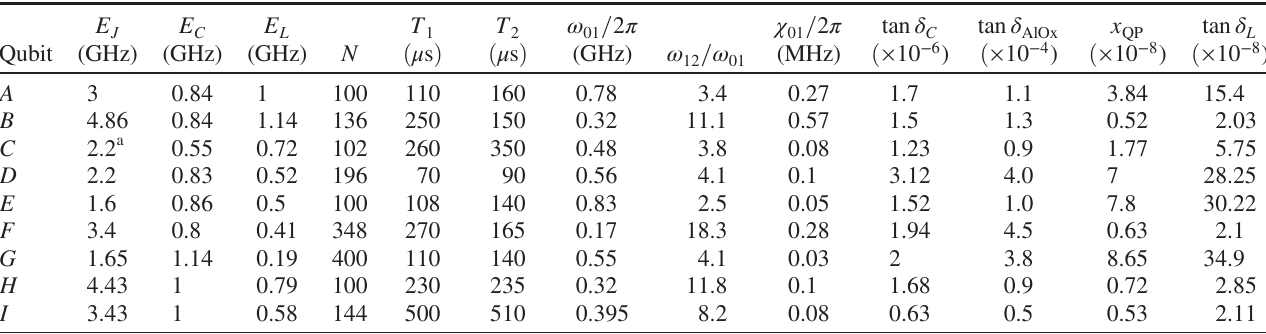
, E , E are obtained from spectroscopy fits; the qubit dispersive J C L